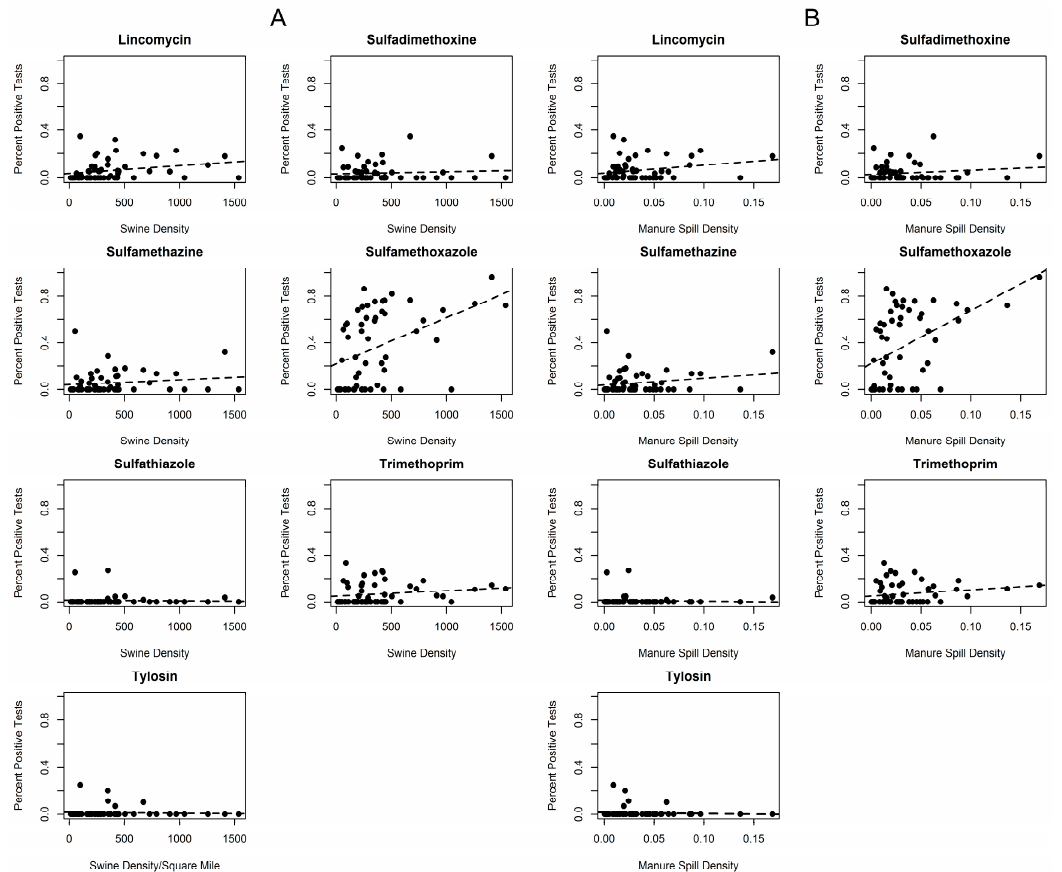
Figure 9. Percentage positive tests for antibiotics in watersheds versus swine AU density in watersheds ( A ) and manure spill density in watersheds ( B ). A linear regression line is fitted for each antibiotic.